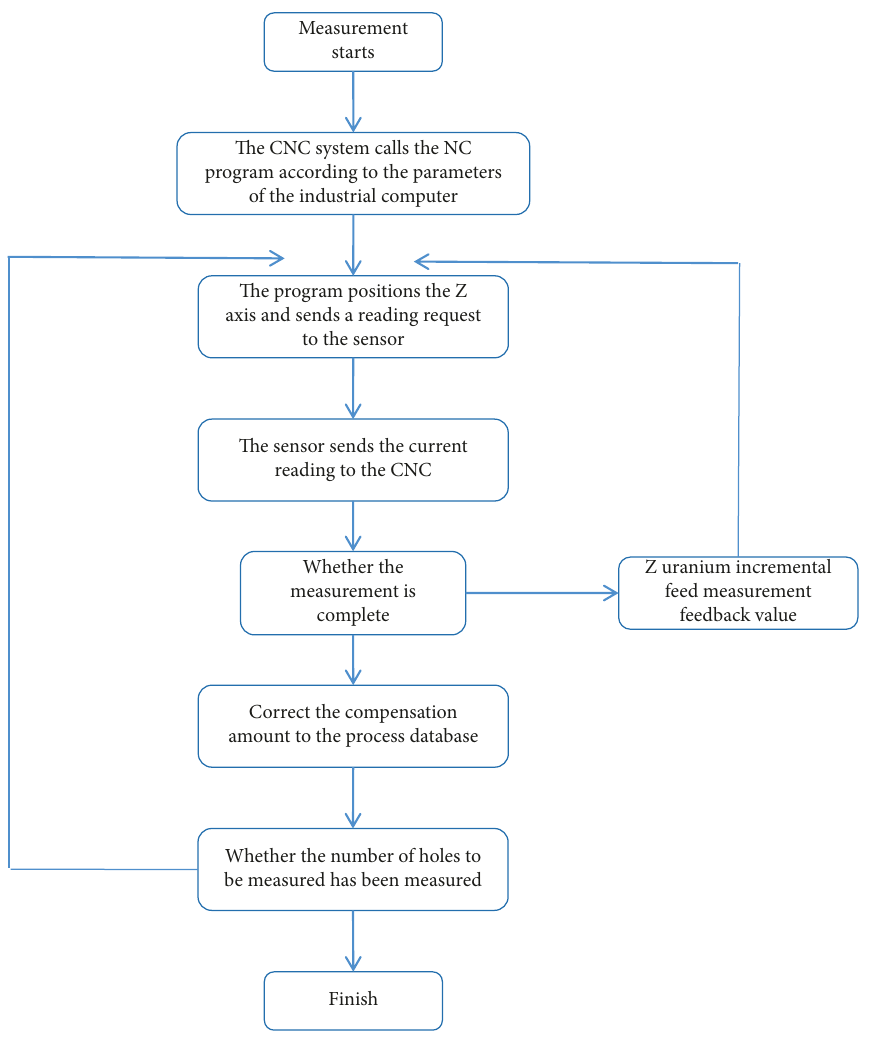
Figure 11: Flow chart of focal length measurement.